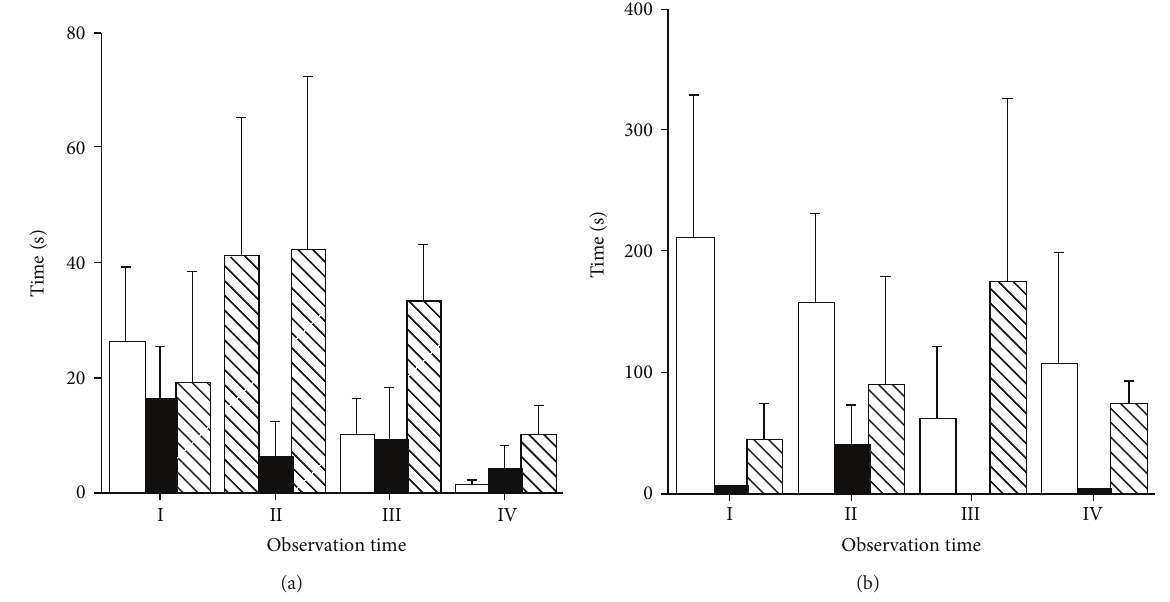
Figure 5: Effect of different types of physical exercise (race blank; maximal exercise shaded; daily exercise lined) on stereotypic behaviour (a) and exploitive activity (b) of Standardbred horses housed in single stalls. Mares were examined at rest in their stalls (Time I), immediately after exercise (Time II), one (Time III), and two hours (Time V) after the completion of exercise. Values are expressed as means ±